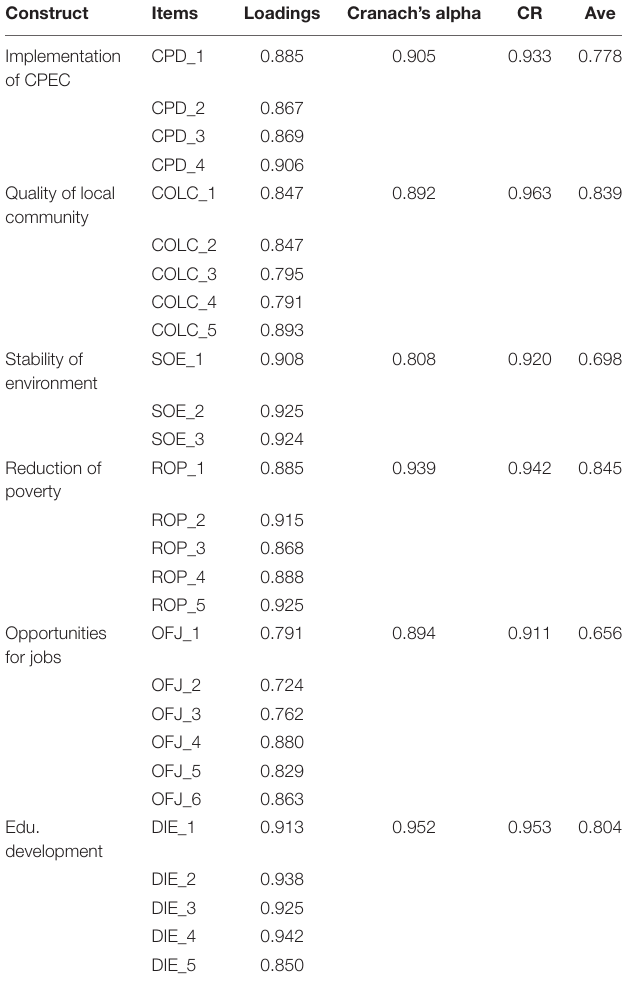
TABLE 3 | The measurement model displays a convergent validity, alpha (_), and